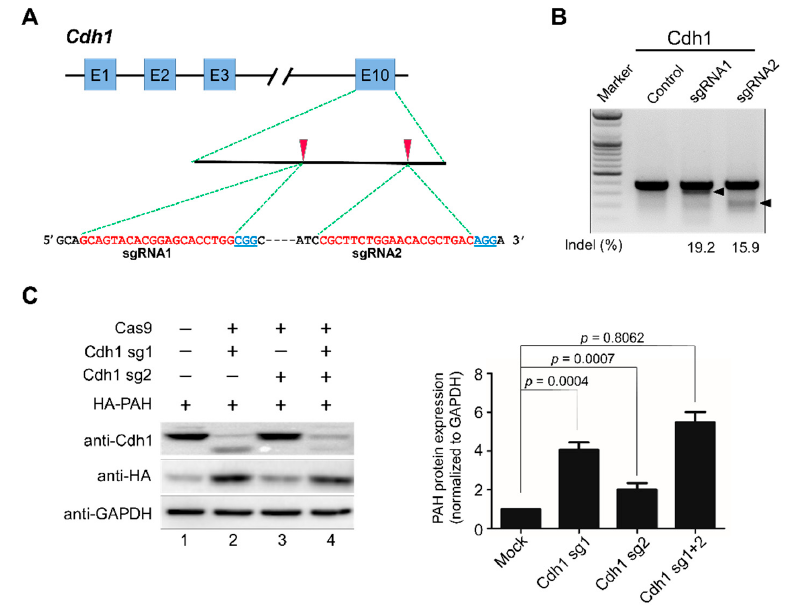
Figure 3. APC / C Cdh1 is a negative regulator of PAH stability. ( A ) Schematic of the RNA-guided engineered nuclease targeting the human Cdh1 gene with designed sgRNA1 and sgRNA2 that target sequences in exon 10. Blue boxes represent exons. Red arrowheads indicate the positions of sgRNAs targeting the top strand. Target sequences are represented in red and PAM sequences are marked by bold blue underlined font. ( B ) The cleavage efficiency of sgRNA1 and sgRNA2 was determined by the T7E1 assay in HEK293 cells after transfection with plasmids encoding Cas9 and sgRNAs. The size marker is shown. Arrows indicate the expected positions of the cleaved DNA bands. The numbers at the bottom of the gel indicate indel percentage measured by band intensity using ImageJ software. Untransfected cells were used as a negative control. ( C ) The knockout e ffi ciency of sgRNAs targeting Cdh1 was determined by Western blot analysis HEK293 cells were transiently transfected with two sgRNAs targeting Cdh1 along with ectopically expressing HA-PAH to check exogenous protein levels. Band intensity was estimated using ImageJ software, normalized with GAPDH, and represented graphically. Data were presented as the mean and standard deviation of three independent